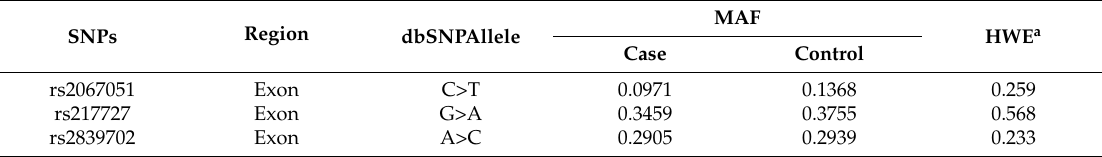
Table 2. Primary information of single nucleotide polymorphisms (SNPs) in H19 gene.